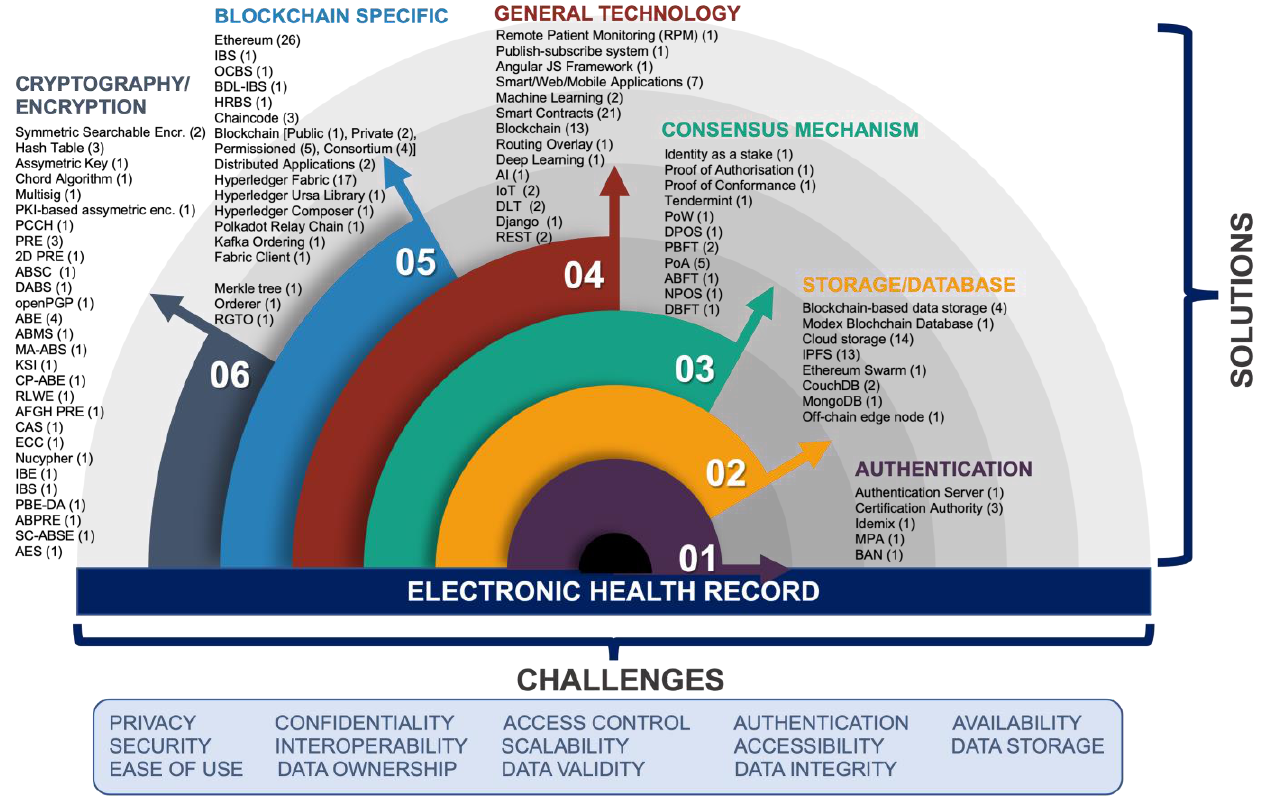
Figure 5. EHR challenges and the technologies used as solutions.